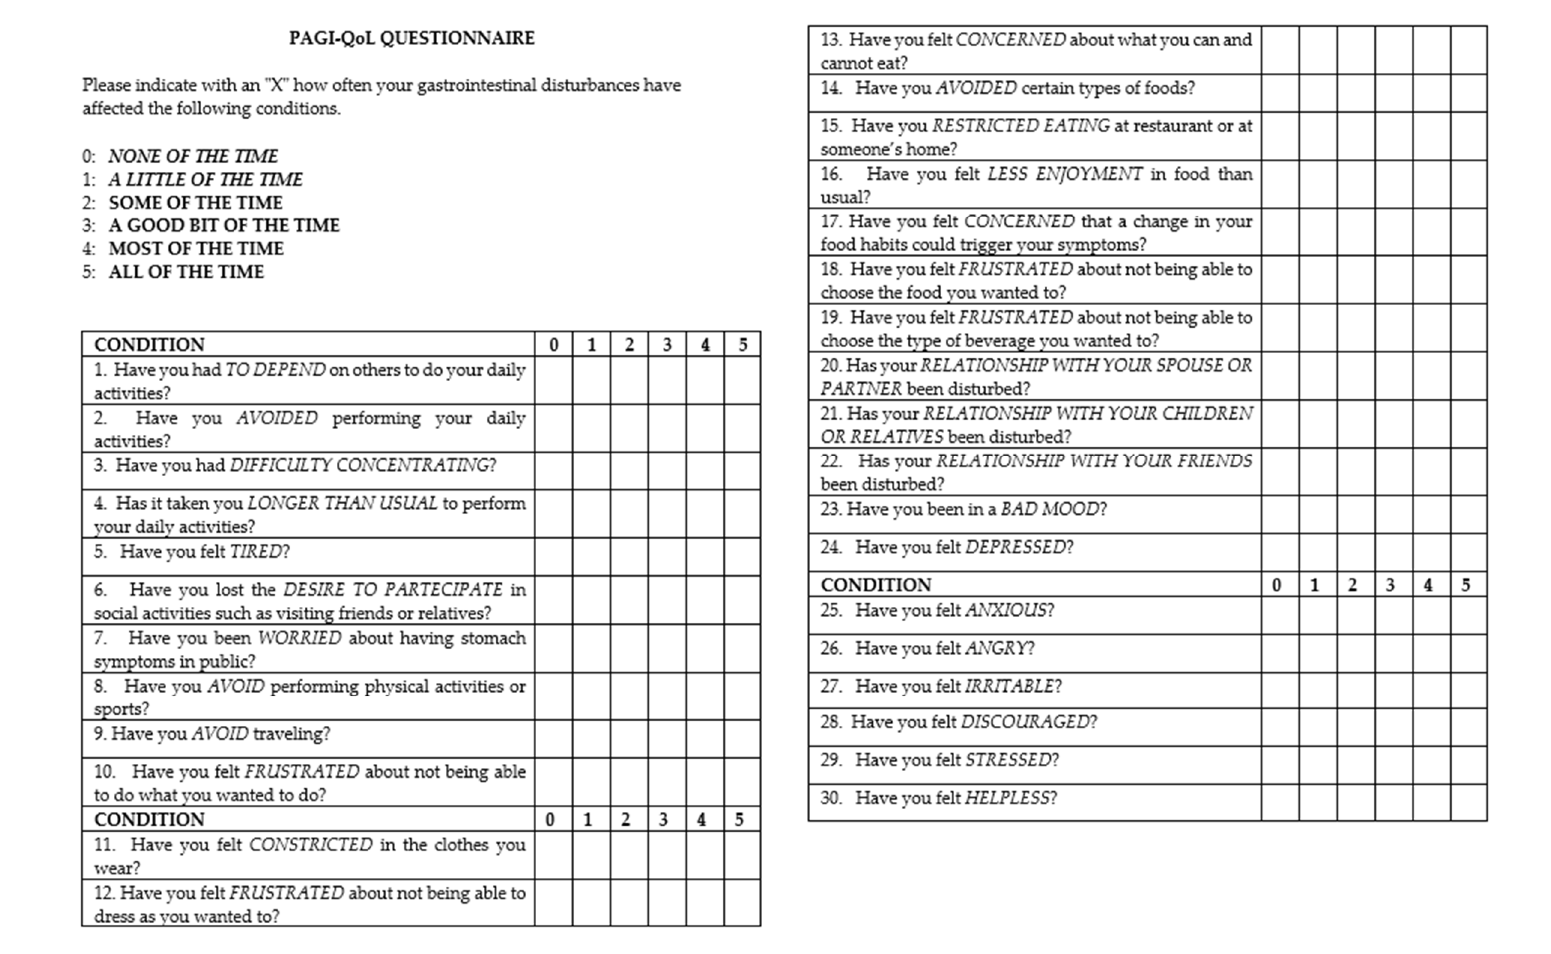
Figure A3. PAGI-QoL Questionnaire.